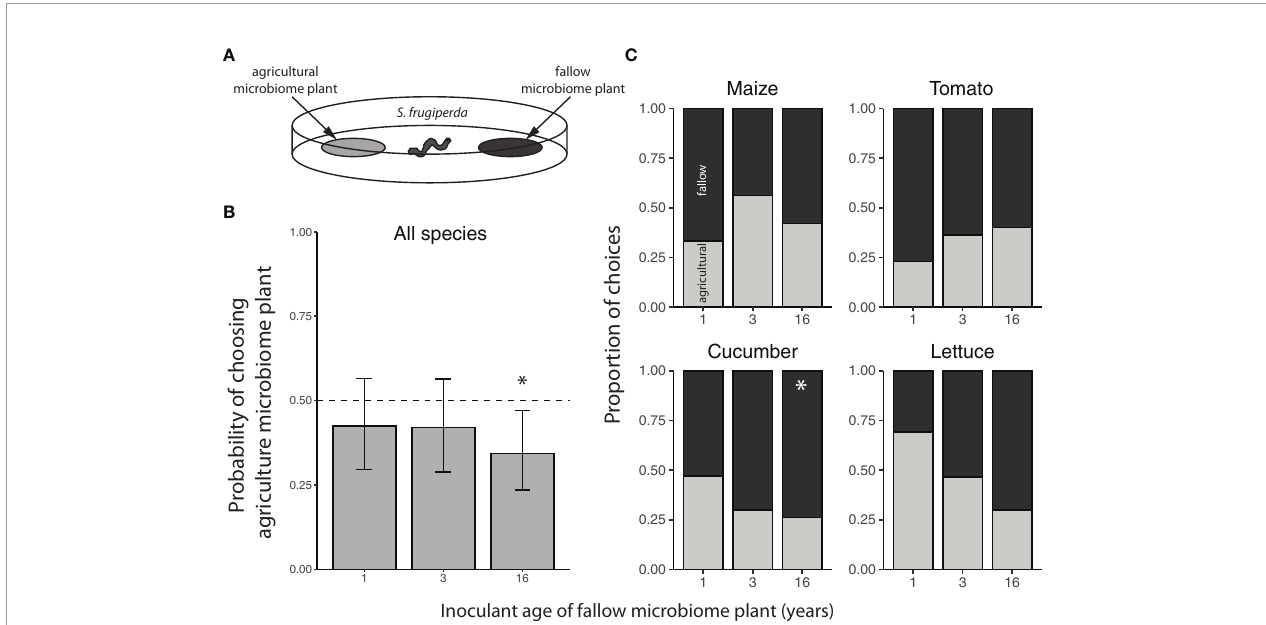
FIGURE 5 | Feeding preference of Spodoptera frugiperda for maize ( Z. mays ), tomato ( S. lycopersicum ), cucumber ( C. sativus ), and lettuce ( L. sativa ) inoculated with agricultural or fallow microbiomes of different ages. (A) Neonatal S. frugiperda larvae were simultaneously presented with a disc of leaf tissue from a plant inoculated with an agricultural soil microbiome and a disc of leaf tissue from a plant inoculated with a microbiome from a fallow fi eld (1, 3, or 16 years post- agriculture) in an arena. All choice tests were performed within plant species. Choices represent the microbiome treatment of the disc each larva was fi rst observed to eat. (B) Probabilities (with 95% con fi dence intervals) of selecting the agriculture microbiome-inoculated plant averaged across plant species; the dashed line indicates an equal preference for agriculture- and fallow-microbiome treated plants. (C) Choices by crop species; light grey bars indicate the proportion of larvae that chose the plant treated with the agricultural soil microbiome whereas the dark grey bars indicate instances in which the fallow microbiome plant was chosen. N = 10-20 tests per plant species × fallow inoculant age level after omitting larvae that did not feed within the 2 h trial. An asterisk (*) indicates a signi fi cant